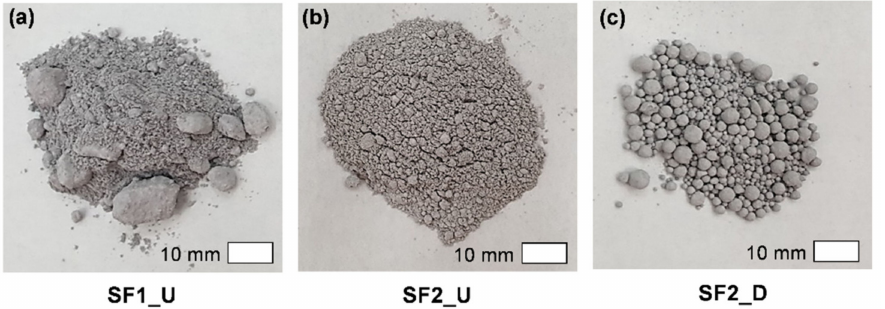
Figure 4. Visual observation of SF samples as a state used for manufacture of UHPFRC: ( a ) SF1_U, ( b ) SF2_U, and ( c )